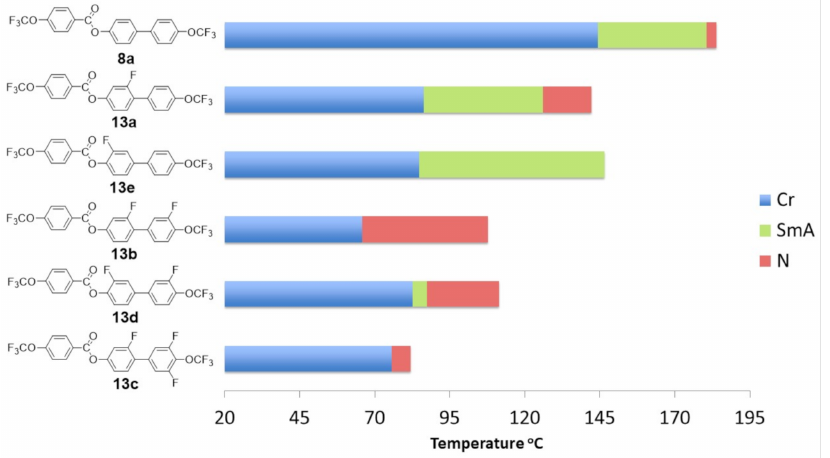
Figure 9. The influence of the number and position of fluorine atoms in the lateral position on the mesomorphic properties for selected group 1 derivatives (direct connection between benzene